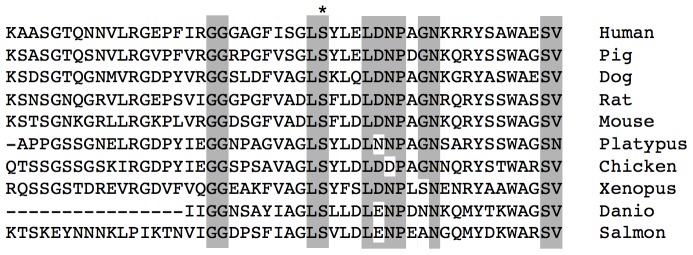
Conservation of the complement component 7 protein.Multiple sequence alignment highlighting the amino acid conservation of the complement component 7 protein (C7) across a broad spectrum of animal species, including mammal, bird, amphibian and fish. The SNP rs1063499 (asterisk) is conserved across these species, suggesting functional conservation of this amino acid.